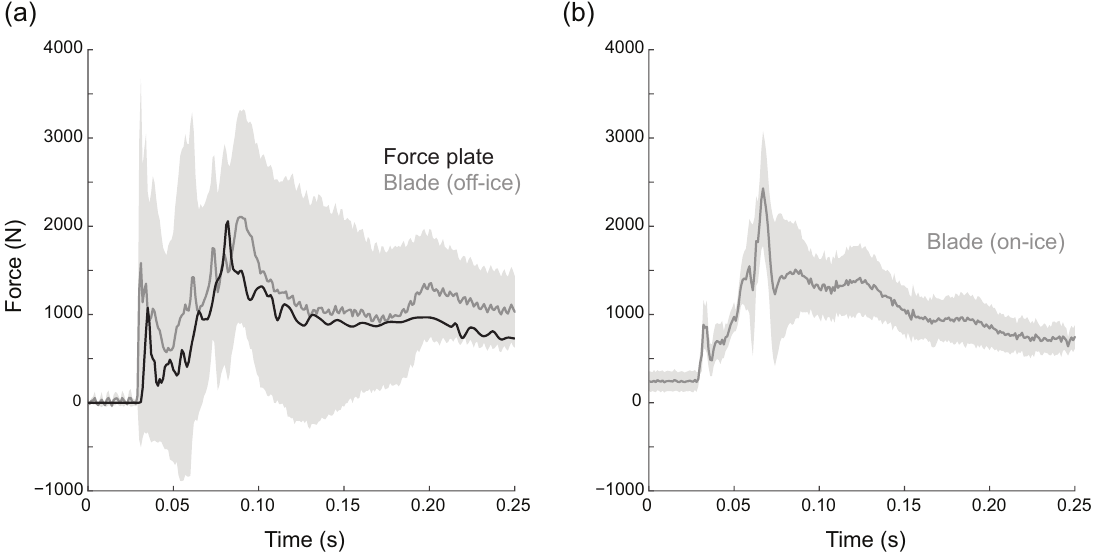
Figure 8. Drop-loading calibration applied to two example jumps. ( a ) O ff -ice jump from a box onto a force plate. The blade force roughly matches the force plate force in timing and magnitude. ( b ) On-ice double flip jump, for which there is no force plate equivalent. The peak values are similar to the o ff -ice jump, but the initial toe contact peak is much smaller. The shaded areas represent the standard deviation of the force estimates calculated from the nine drop trial calibration